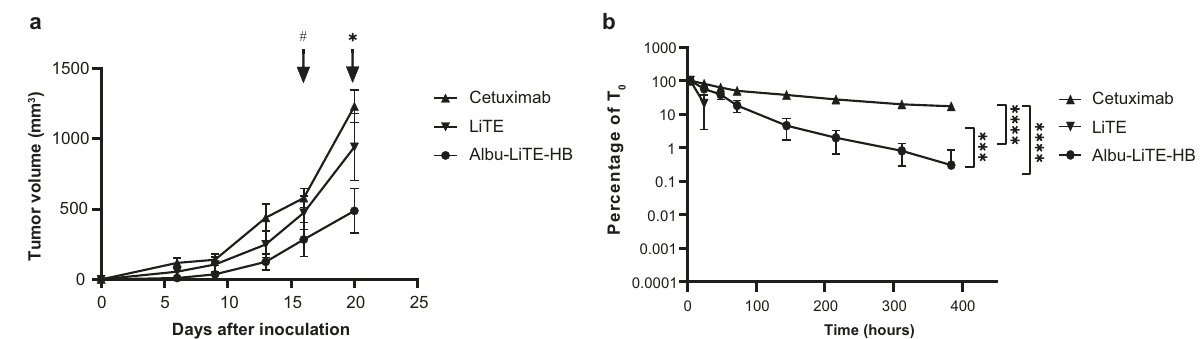
Fig. 7 Growth inhibition of HT-29 tumours in AlbuMus RAG1 KO mice and serum detection of protein drugs. a HT-29 cells mixed with human PBMCs were inoculated subcutaneously in immunocompromised AlbuMus RAG1 KO mice. Animals were divided into three groups ( N = 6) and injected with cetuximab, LiTE or Albu-LiTE-HB at day 0. Tumour growth was monitored and measured by calliper every 3 – 4 days. A two-way ANOVA with Holm-Sidak post hoc analysis was used to compare tumour volume between the three groups. Time points where the Albu-Lite-HB tumour group is comparably smaller have been marked * p < 0.01, # p < 0.05. Error bars represent SEM. b Blood samples were drawn at the 9 time points (1 h, 4 h, 24 h, 48 h, 72 h, 144 h, 216 h, 312 h, 384 h). Full size construct was detected in serum by sandwich ELISA. The LiTE molecule was not detectable in samples drawn after 24 h. The highest concentration in the serum was seen in the 4-hour sample that were set as T 0 . Statistical differences between the constructs, detected in serum over time, were analysed using a two-way ANOVA with multiple comparisons and Tukey ’ s post hoc correction, **** p < 0.0001, *** p = 0.001. Error bars represent standard deviations. All statistical analyses were made in GraphPad prism v.